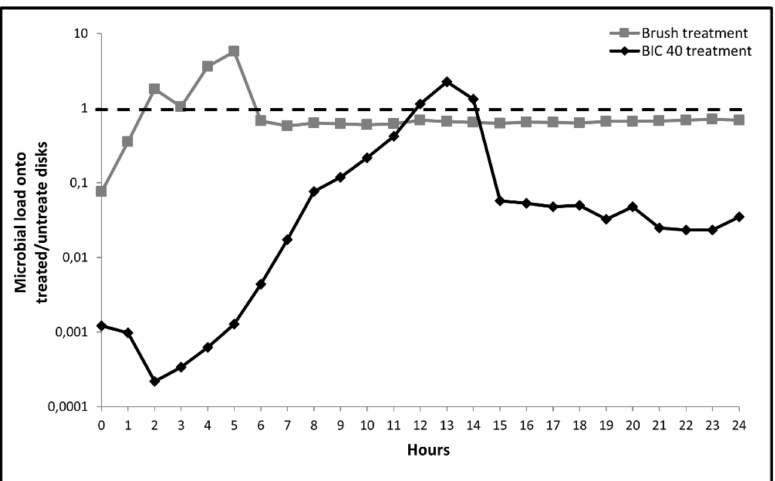
Figure 2. Kinetic evaluation of P. aeruginosa biofilm re-growth onto titanium disks, following decontamination by Ni-Ti Brush and AirPol BIC-40 systems. Microbial load was kinetically assessed on treated and untreated disks, by bioluminescence assay. The results are expressed as microbial load ratio between treated and untreated disks. The ratio = 1 (dotted line) indicates superimposable microbial load in treated and untreated